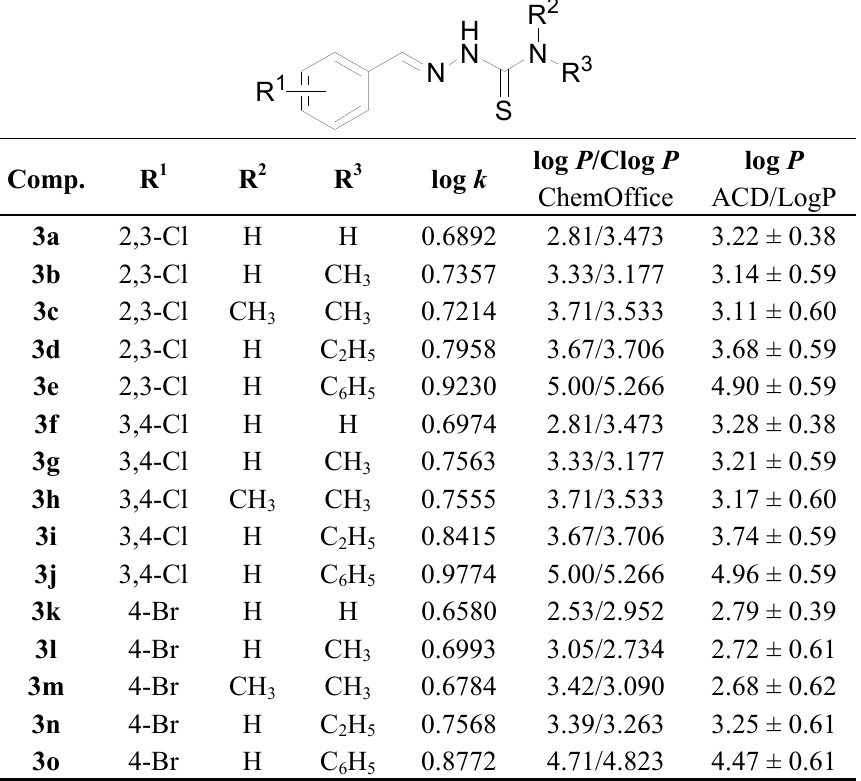
Table 1. Structure of aryl compounds 3a – o and comparison of the calculated lipophilicities (log P /Clog P ) with determined log k